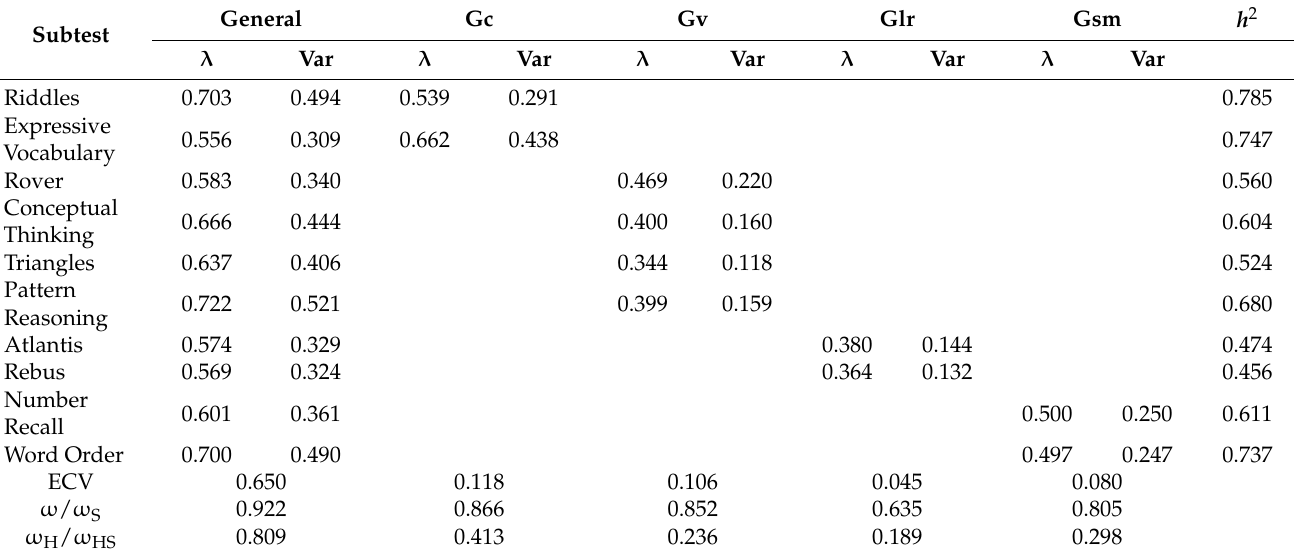
Table 9. Bifactor model of KABC-II core subtests: Factor loadings and sources of variance at age